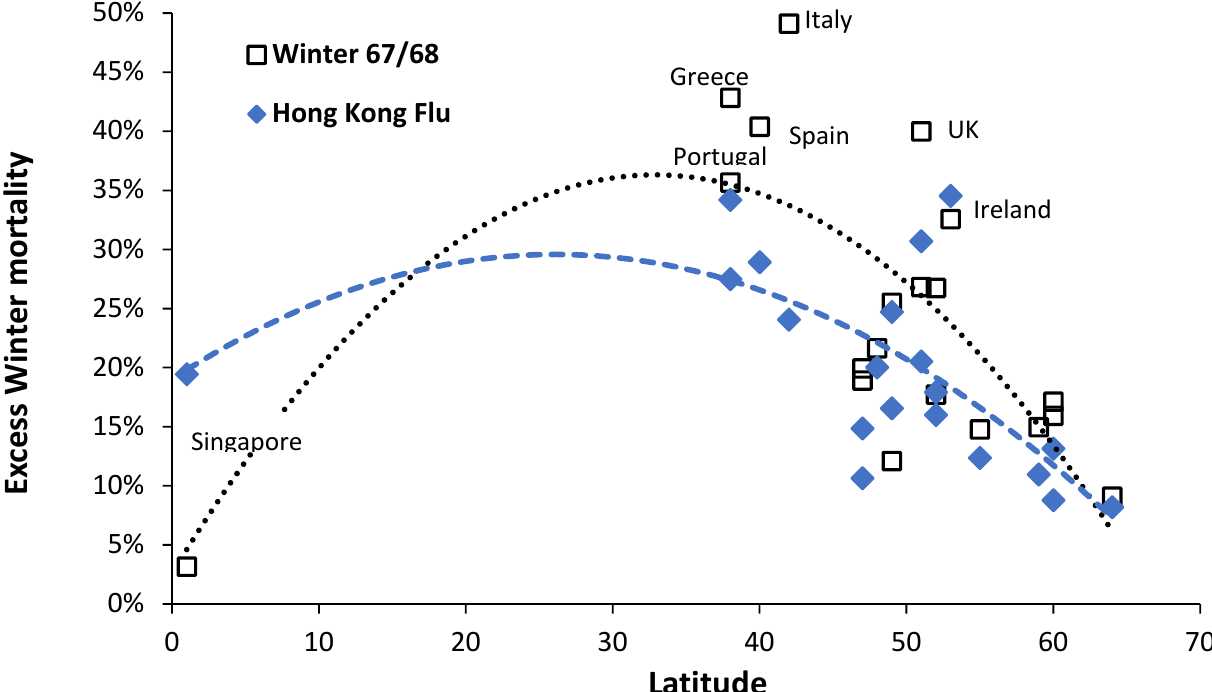
Figure 9. Excess winter mortality before and during the Hong Kong influenza pandemic. Black dotted line is line of best fit for winter of 1967/68, while blue dashed line is line of best fit for the pandemic year.